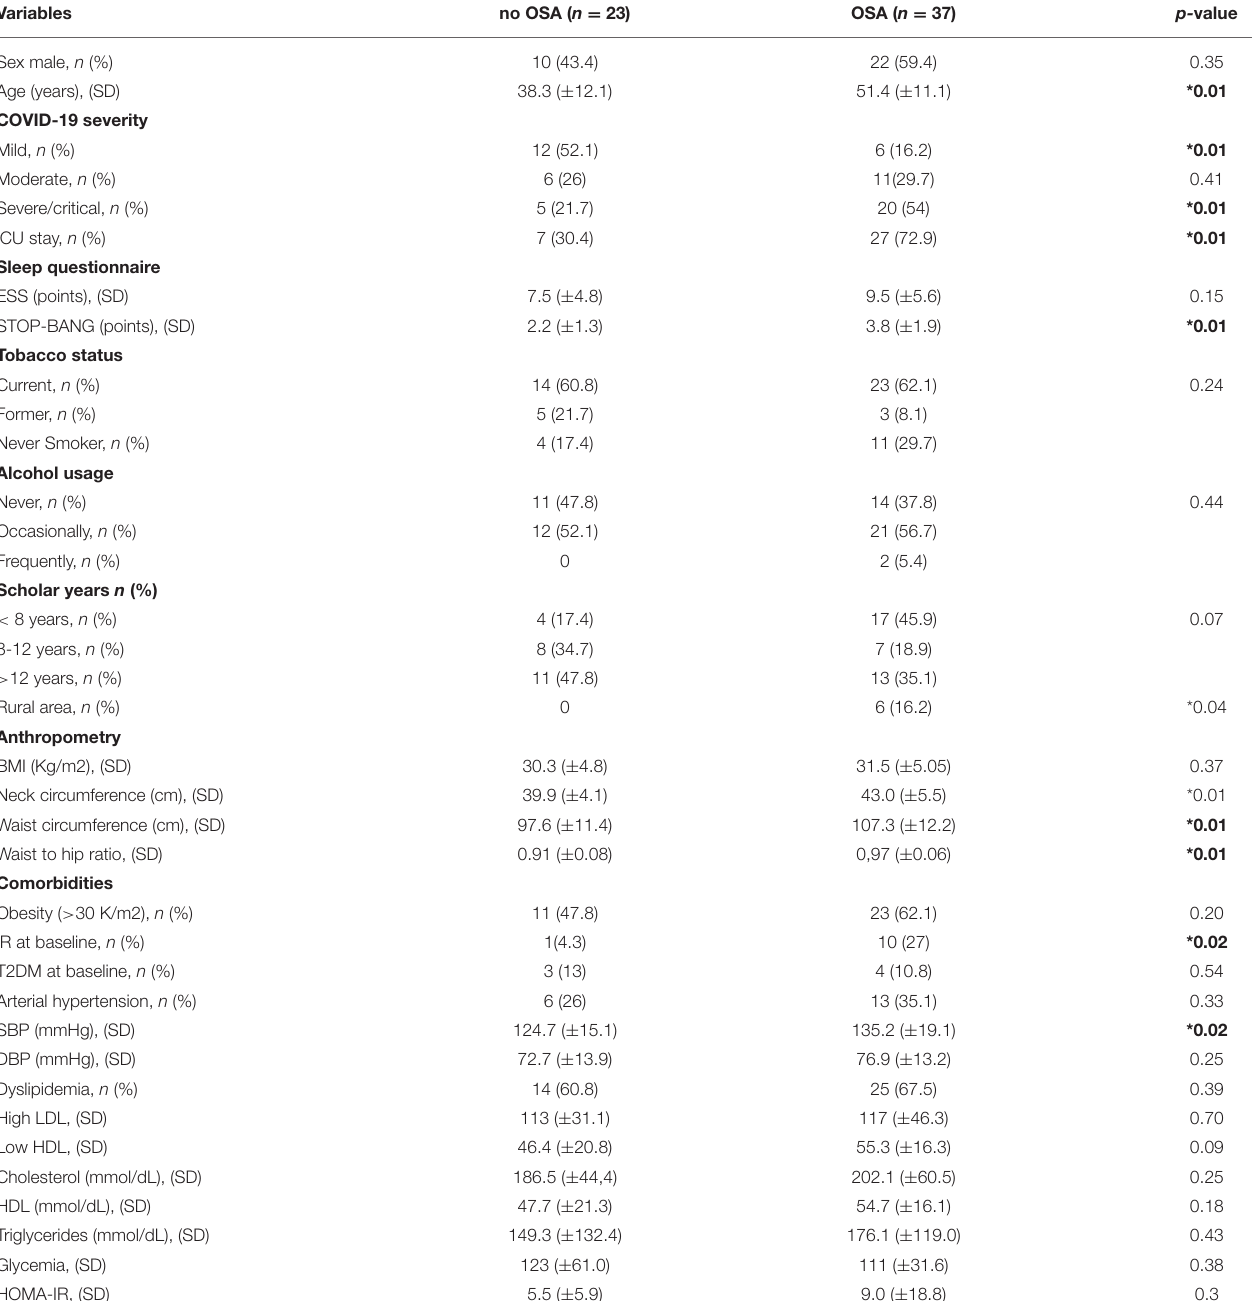
TABLE 3 | Clinical characteristic between OSA and non OSA group of the complete cohort ( n = 60).